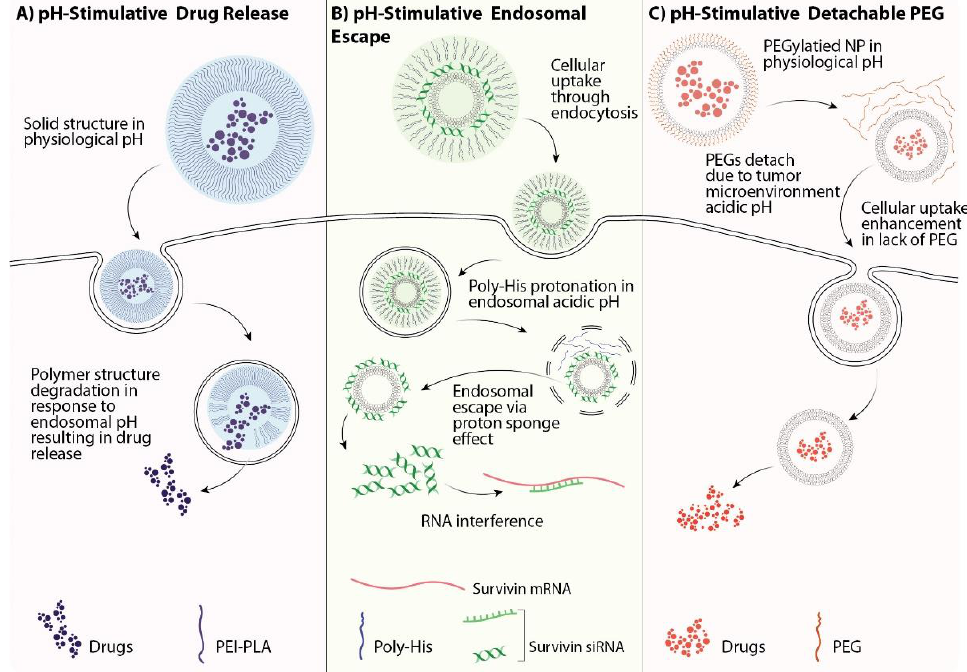
Figure 5. Common pH-responsive nanoparticle (NP) strategies. ( A ) The most common application of pH-responsive NPs is for controlled drug release, which is achieved using pH-simulative NPs that are stable in a physiological pH but degrade in the acidic pH of the tumor cell intracellular environment. ( B ) DNA and RNA delivery is associated with endosomal entrapment challenges. Utilizing a poly-His module in the nanoformulation can overcome this challenge via the proton sponge effect that results from poly-His protonation in endosomal acidic pH, and increases endosomal membrane permeability, resulting in endosomal escape of the NPs. ( C ) PEGylation is the most common strategy to increase the biocompatibility and circulation half-life of NPs. However, it can decrease the cellular uptake of NPs. To address this issue, a common approach is the PEGylation of nanoparticles using a pH-sensitive linker that remains stable in physiological pH and degrades in response to the acidic pH of the tumor microenvironment.